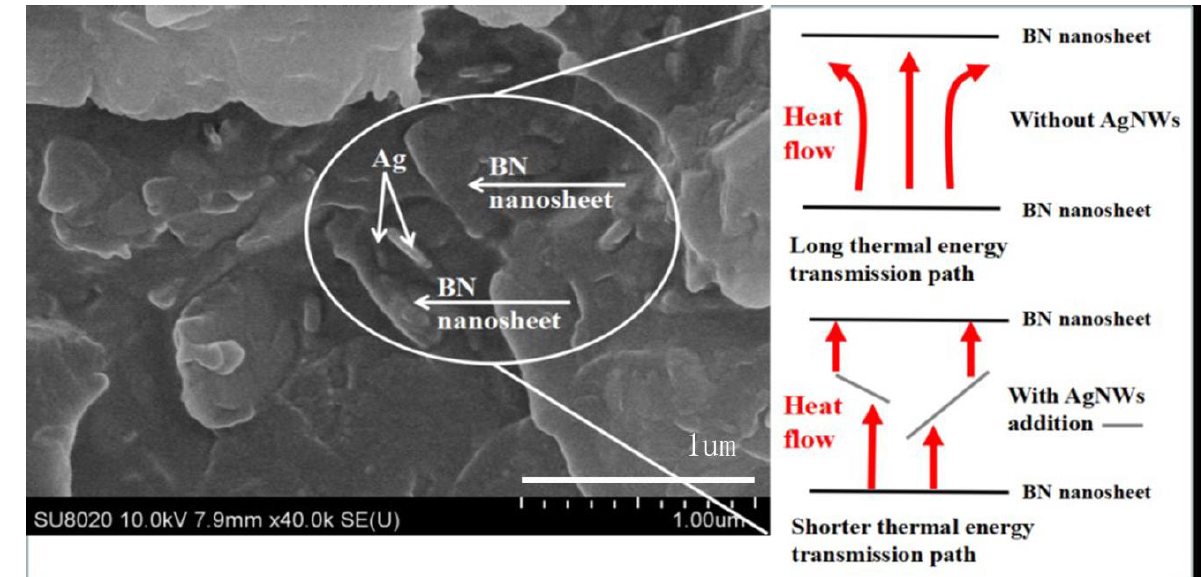
Figure 8. Thermal conduction mechanism of BN/AgNWs/EP composites.